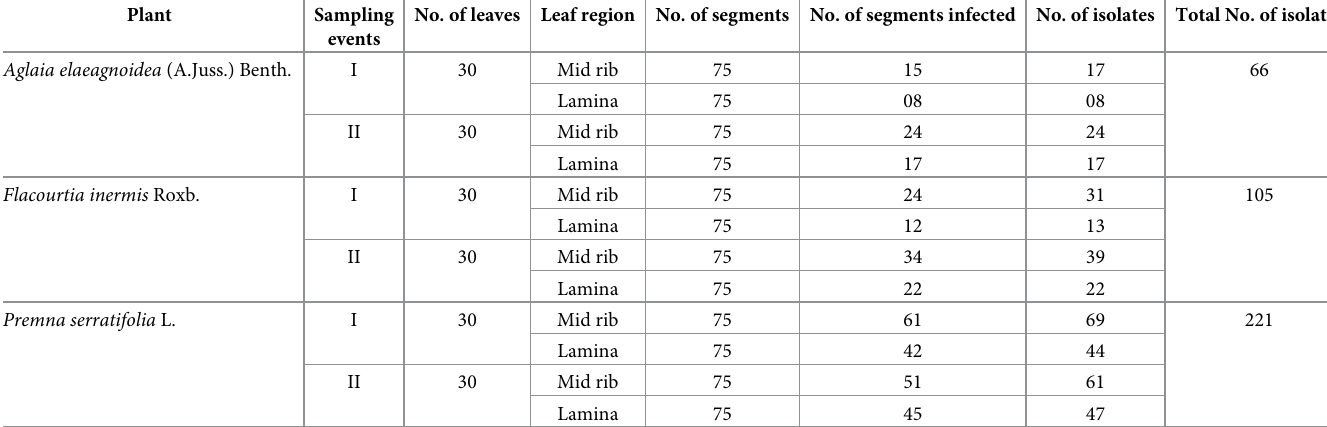
Table 1. Sampling effort and number of foliar endophytic fungi isolated from A . elaeagnoidea , F . inermis , and P . serratifolia . Plant Sampling events Aglaia elaeagnoidea (A.Juss.) Benth.